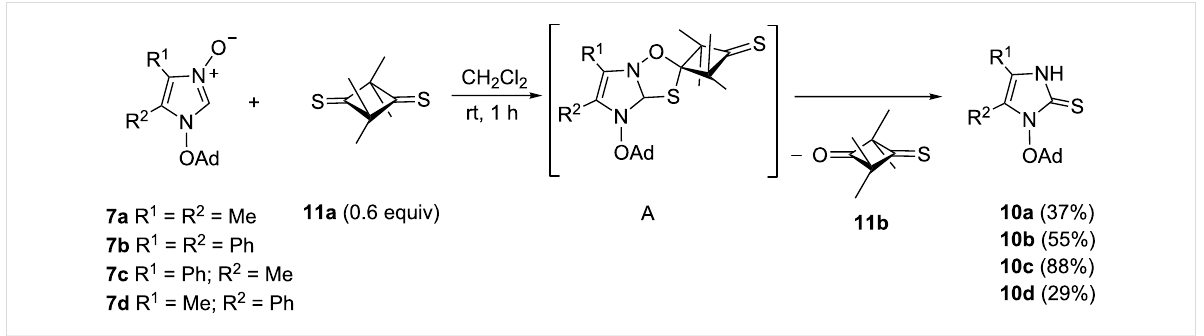
Scheme 5: Conversions of imidazole 3-oxides 7a – d into 1-(adamantyloxy)imidazole-2-thiones 10a – d via sulfur transfer